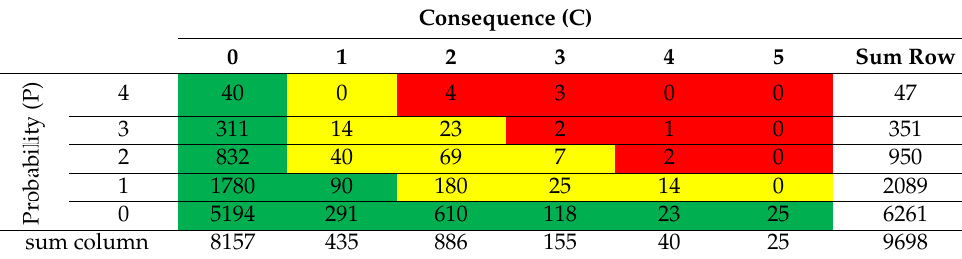
Table A4. Risk matrix based on LCI and flow (equal weight, 50%) at time 17.00.